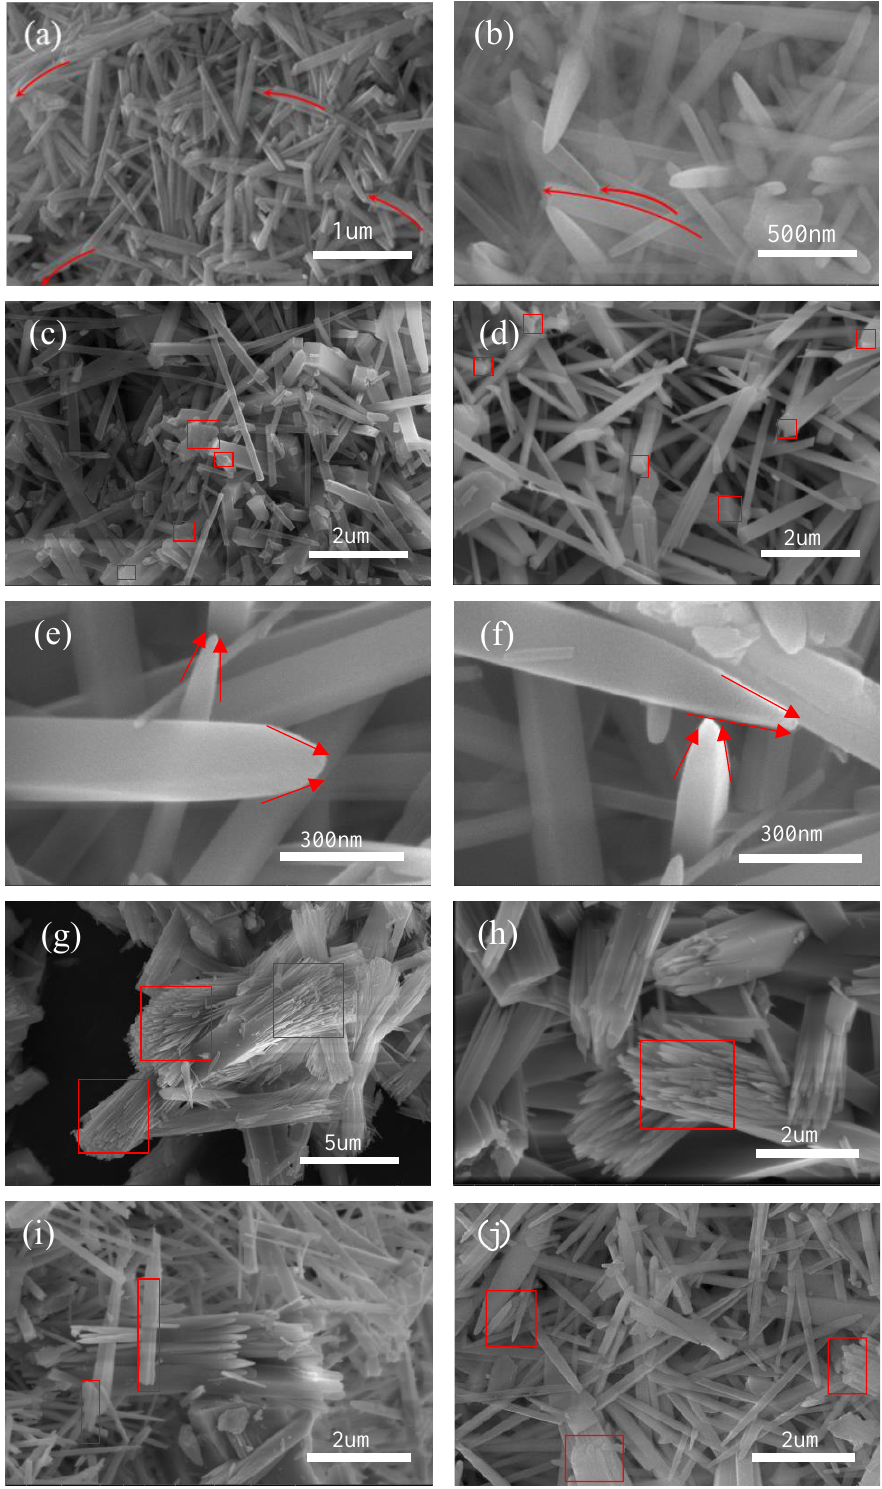
Figure 4. SEM images of various special morphological structures of mullite whiskers: ( a , b ) Whisker twist; ( c , d ) whisker tip droplets; ( e , f ) the top angles of the whiskers; ( g , h ) secondary growth of whiskers; ( i , j ) stacking